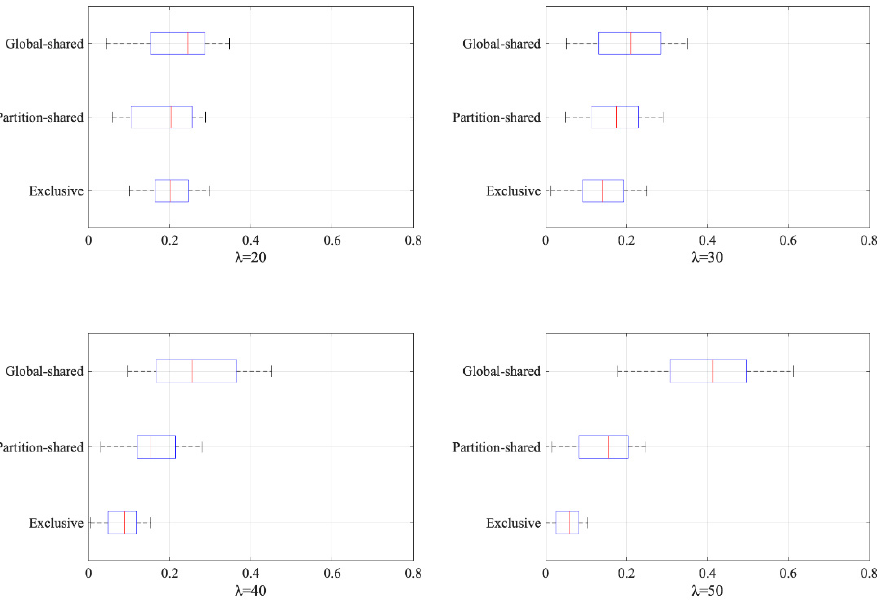
Figure 10. Aircraft Fuel Consumption and Carbon Emissions under Different Procedures and Flight Frequencies.